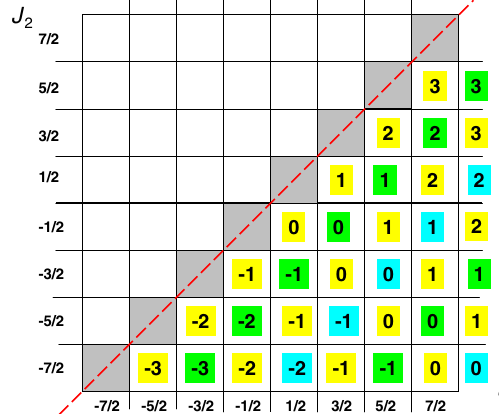
FIG. 3. Schematic illustration of the invariant two-particle states j M; γ i (with integer M and family index γ ¼ 1 , 2, 3) [see Eq. (29)] in the J 1 - J 2 plane. These states span the complete two-particle Hilbert space. Our ordering convention J 1 > J 2 implies that only states below the main diagonal (dashed red line) appear. Yellow cells correspond to γ ¼ 1 , where the respective numbers indicate M . Green (blue) cells refer to γ ¼ 2 ( γ ¼ 3 ). The interacting ground state has γ ¼ 1